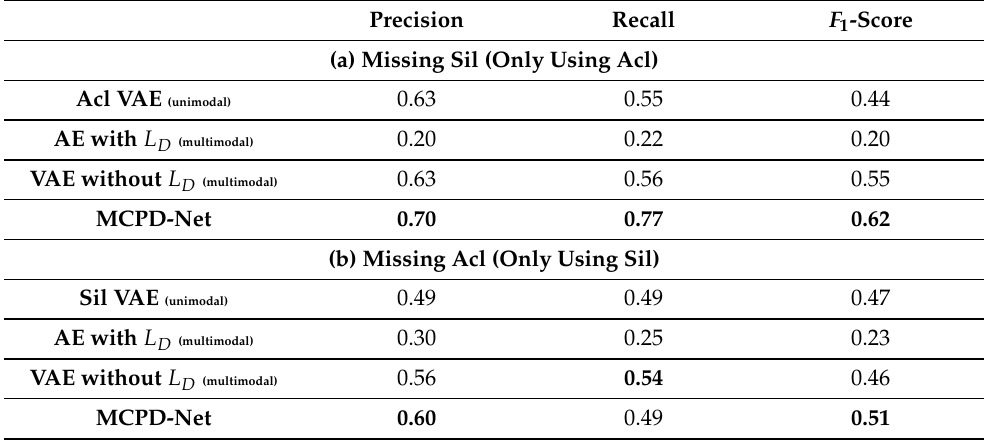
Table 4. Performance of MCPD-Net when silhouette and accelerometer data are completely missing. This demonstrates an overall improvement by our proposed